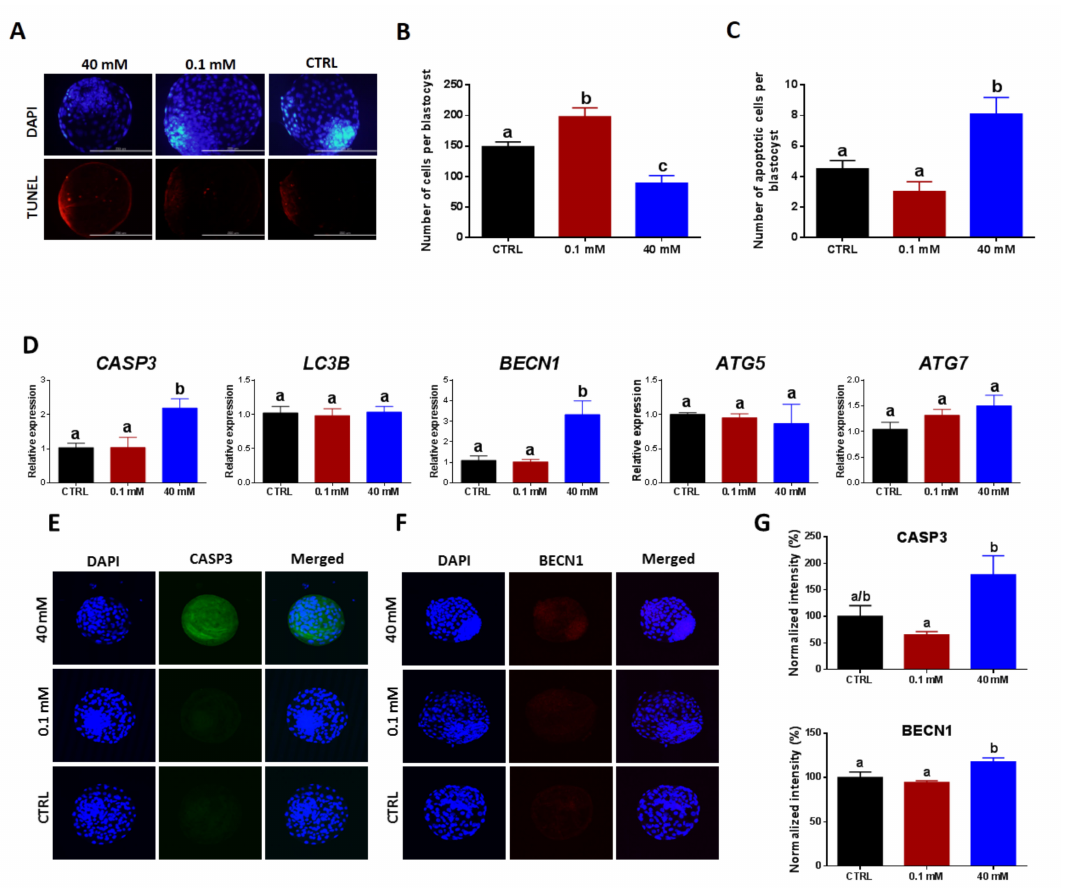
Figure 6. E ff ect of NAM administration during IVM on apoptosis- and autophagy-related genes / proteins in day-8 embryos. ( A ) Terminal deoxynucleotidyl transferase dUTP nick-end labeling (TUNEL) staining as indicator for DNA fragmentation in blastocysts; original magnification 400 × . ( B ) The total number of cellsandthenumberofapoptoticcells( C )perblastocyst. ( D )RelativemRNAlevelsofdi ff erentapoptosis ( CASP3 )- and autophagy ( LC3B, BECN1, ATG5, and ATG7 )-related genes. ( E , F ) Immunofluorescence of CASP3 and BECN1. ( G ) Integrated optical density of CASP3 and BECN1 in NAM-treated (40 and 0.1 mM) and control groups. Original magnification 100 × . Superscripts with di ff erent letters indicate statistical